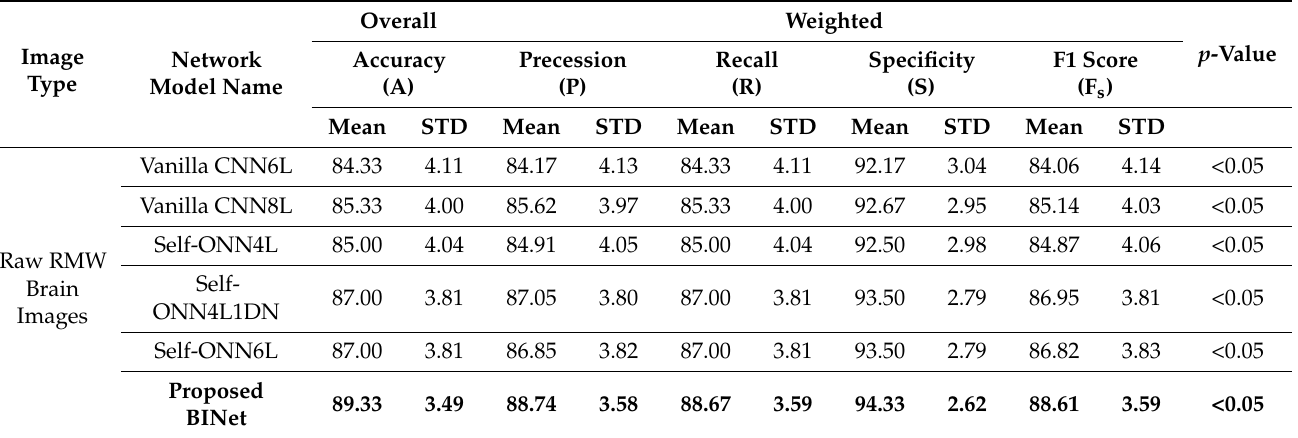
Table 8. Statistical classification results of all models for the raw RMW brain images. Bold represents the best performing model.